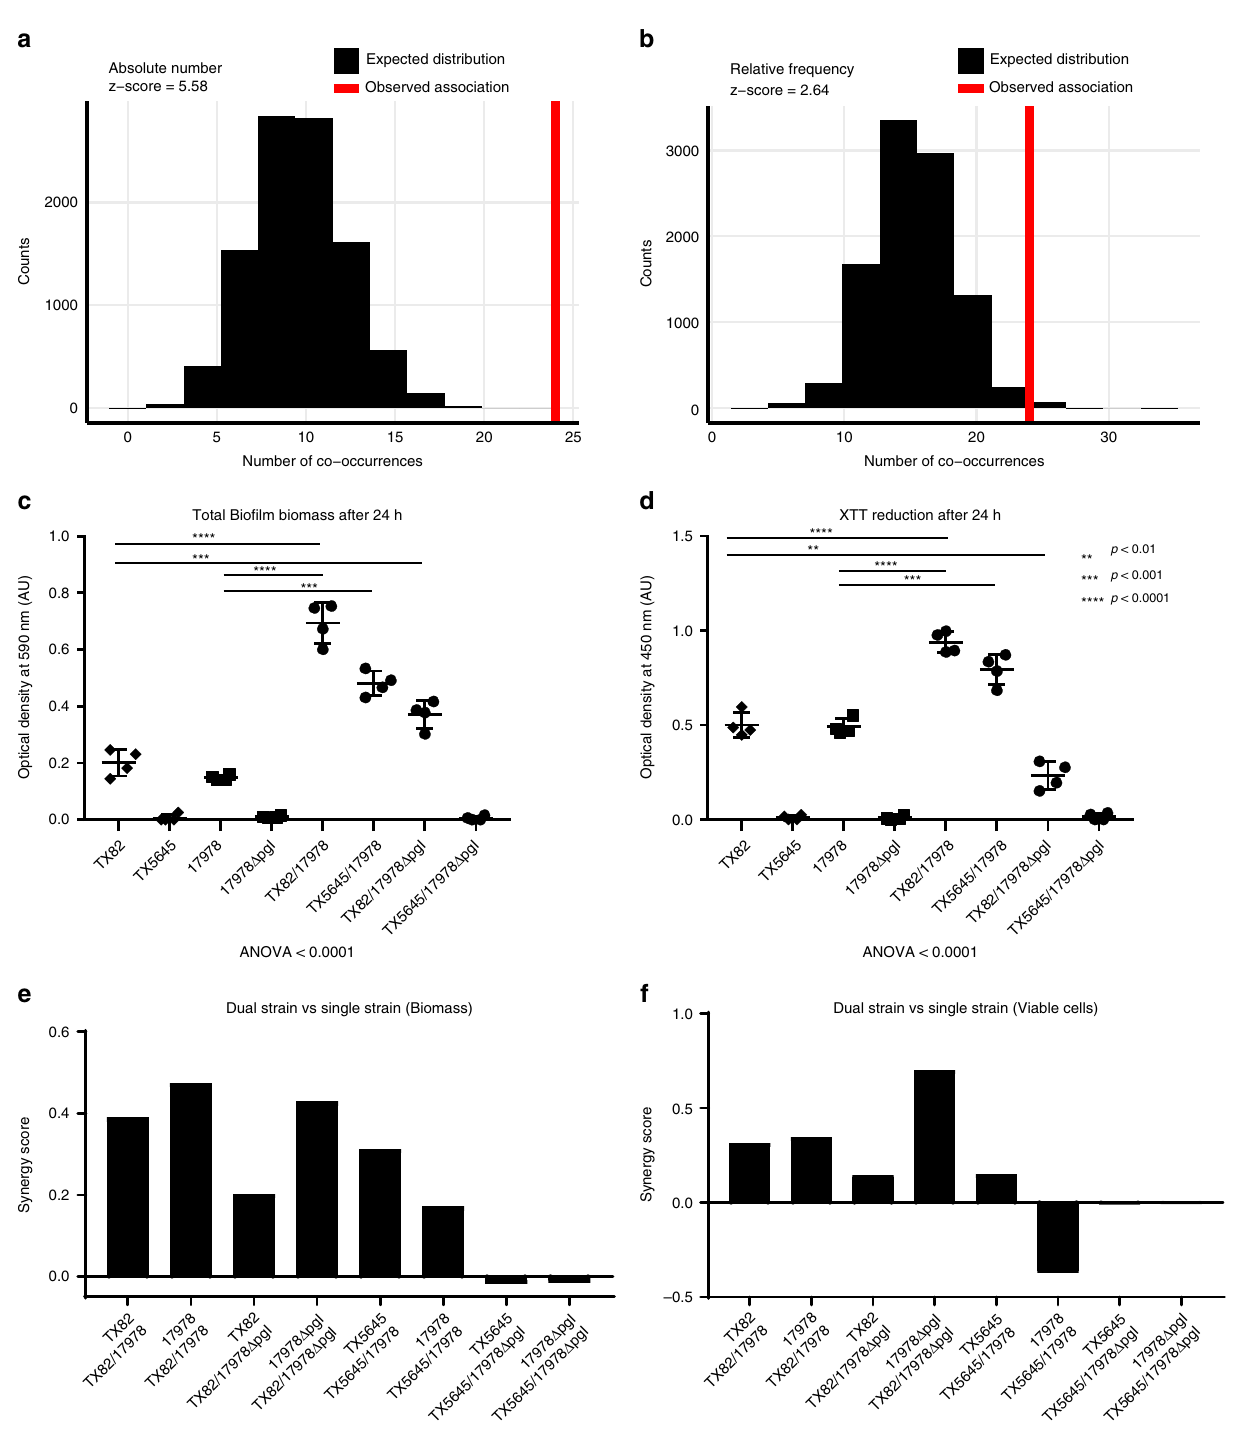
–0.50.00.51.0 Fig. 9 Synergistic bio fi lm interactions for A. baumannii and E. faecium predicted by surface collections. Permutation test of co-association between A. baumannii and E. faecium on surfaces conducted using species a absolute counts and b relative species frequencies. The expected distribution of the number of co-occurrences is shown in red and the observed number of co-occurrences in the dataset is shown as a vertical blue line. Total crystal violet stained c bio fi lm biomass and d XTT reduction for A. baumannii and E. faecium model bio fi lm strains grown in single and in co-culture ( P -values were generated using unpaired, nonparametric Mann – Whitney statistical tests are indicated using the following mapping: **<0.01, ***<0.001, ****<0.0001). y - Axis for both plots is optical density at 590 nm and 450 nm, respectively, and error bars are 1 standard deviation. Synergy scores of dual vs single strain cultures for e bio fi lm biomass and f viable cells. Source data for all panels are provided in the source data fi